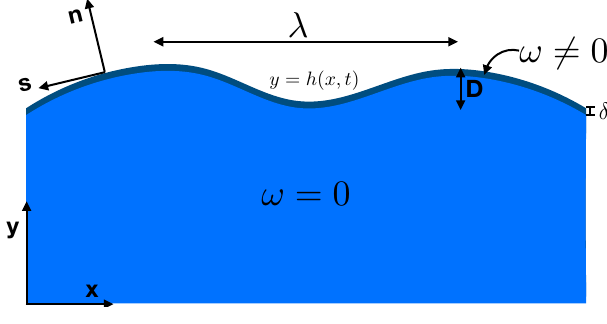
Figure 3: Surface waves with boundary